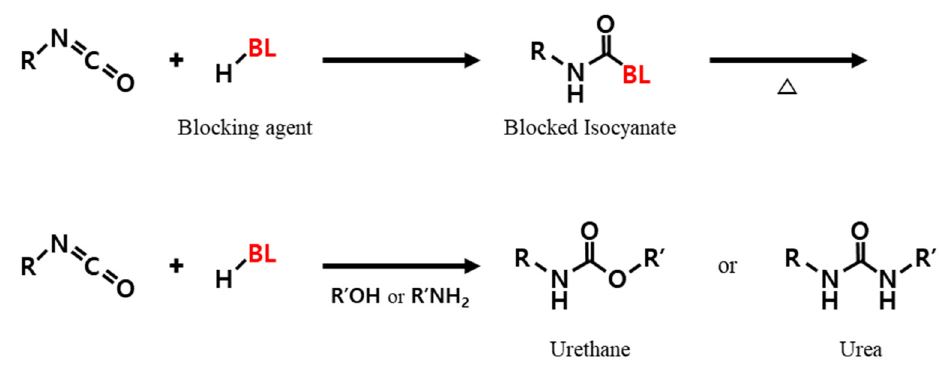
Figure 2. Blocking and reactivation reaction mechanism of the isocyanate groups.